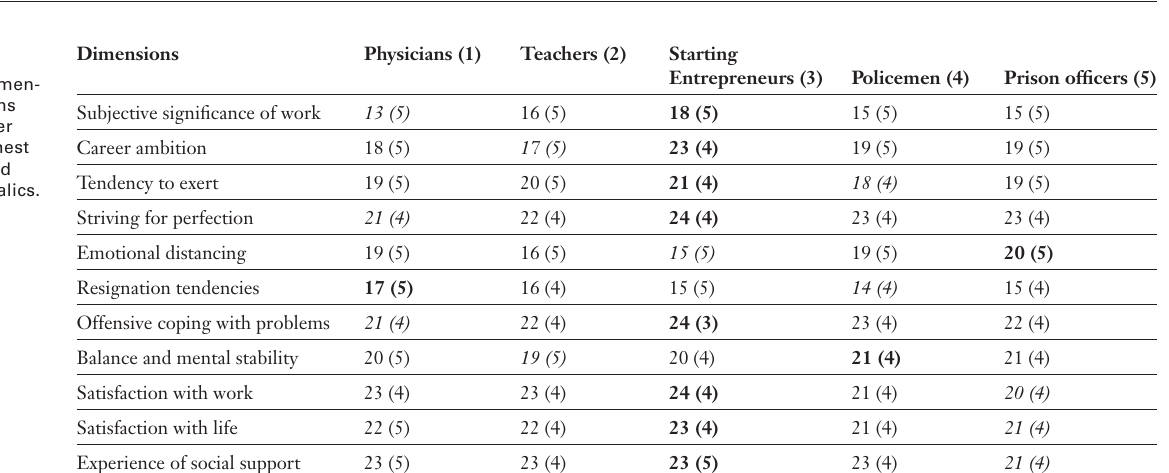
Figure 1 Experience and behaviour patterns of physicians compared to other professions. Type G: healthy pat- tern, Type S: unambi- tious pattern, Risk type A: pattern of overexertion, Risk type B: resigned pattern.